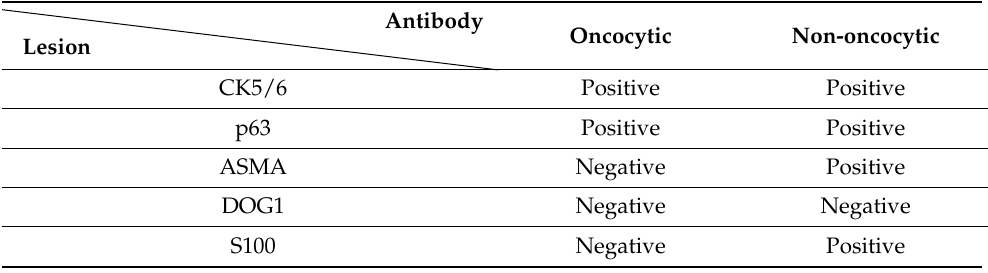
Table 2. Summary of immunohistochemical data in oncocytic and non-oncocytic